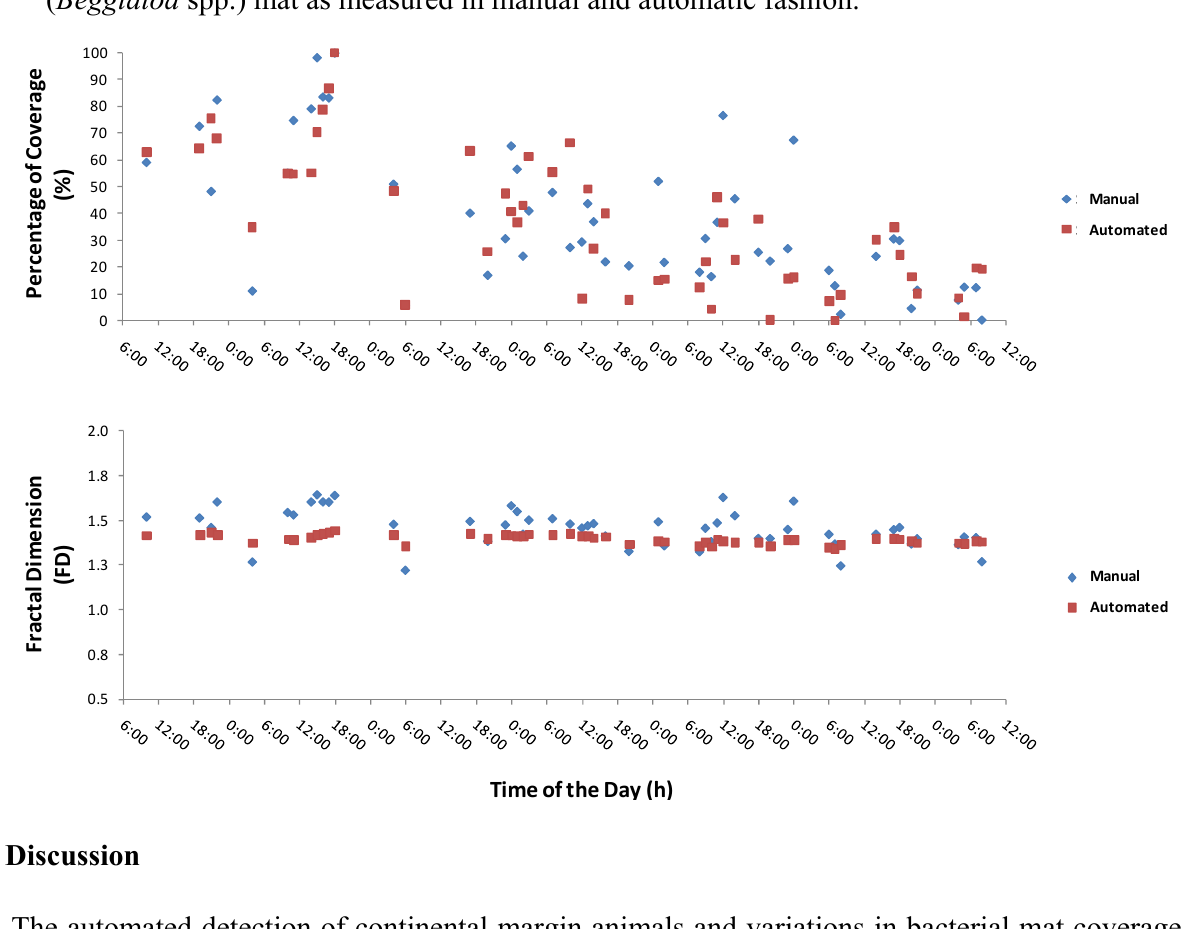
Figure 9. Time series of Percentage of Coverage and Fractal Dimension of bacterial ( Beggiatoa spp.) mat as measured in manual and automatic